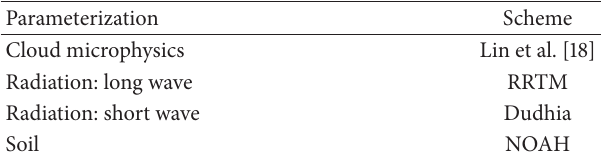
Table 2: Additional information regarding choices of parameteriza- tion schemes used in the ARW-WRF simulations listed in Table